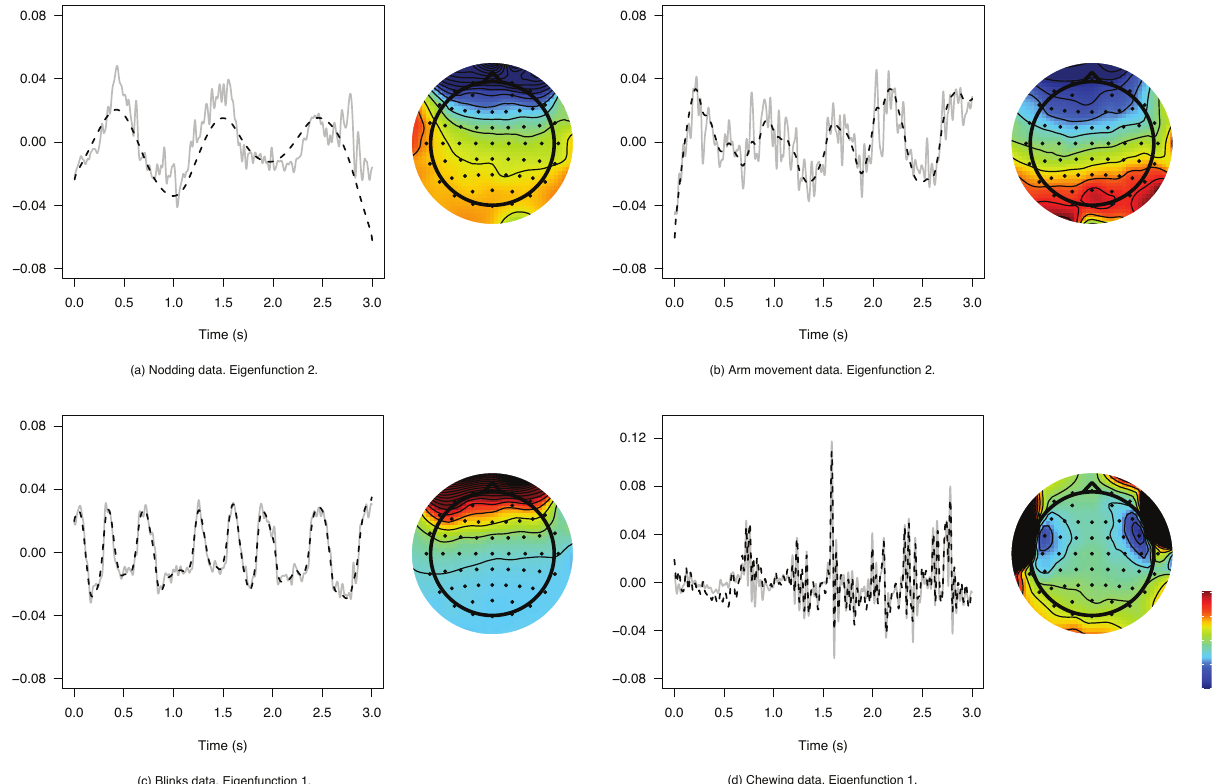
Figure 2. Artifactual eigenfunctions selected from each trial. The unpenalized FICA (grey) and P-spline smoothed FICA (black dashed) decompositions are compared. The scalp maps represent the scores depicted in the spatial electrode domain obtained by projection of the smooth eigenfunctions in the original